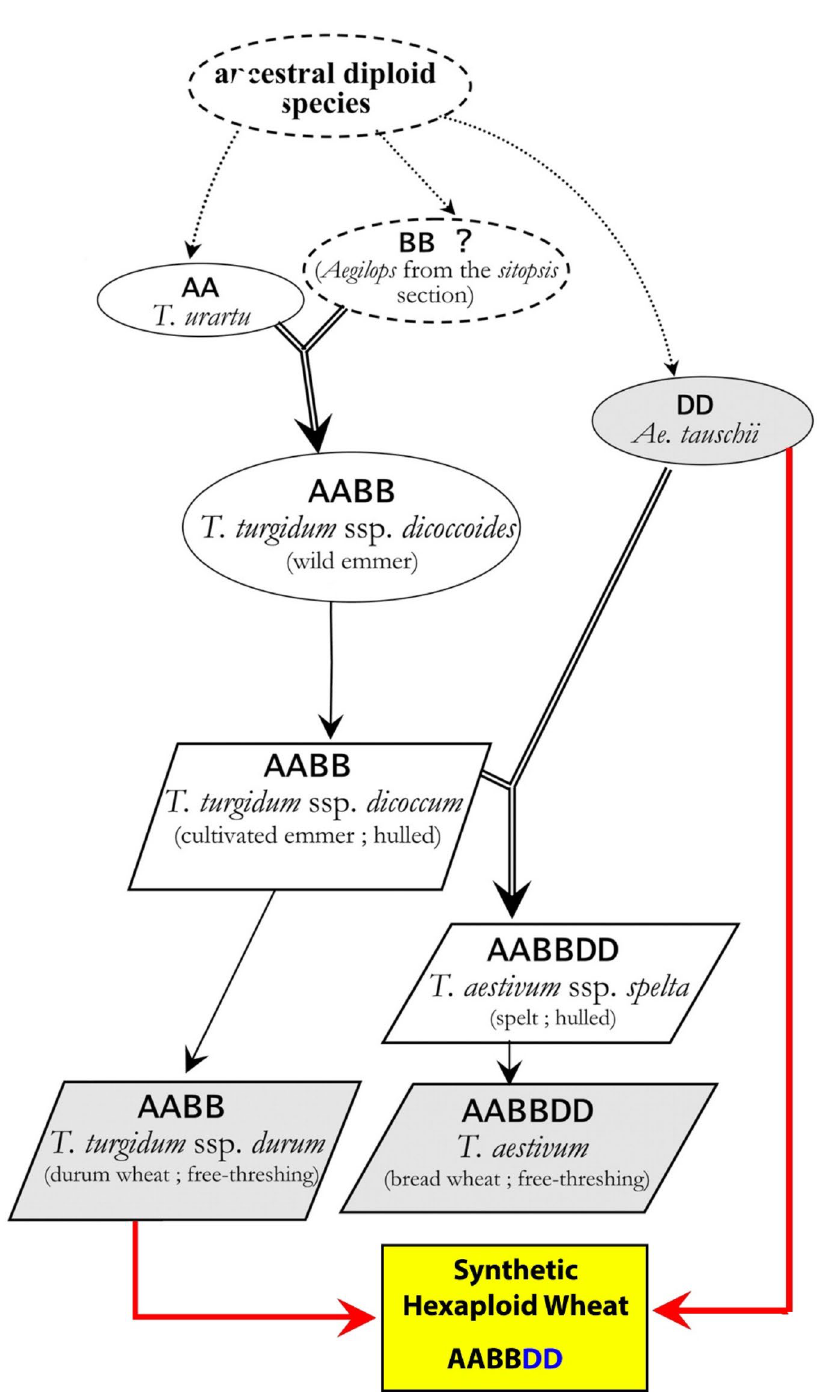
Figure 1. Development of synthetic hexaploid wheat (AABBDD) in comparison with the emulating evolution of the hexaploid wheat